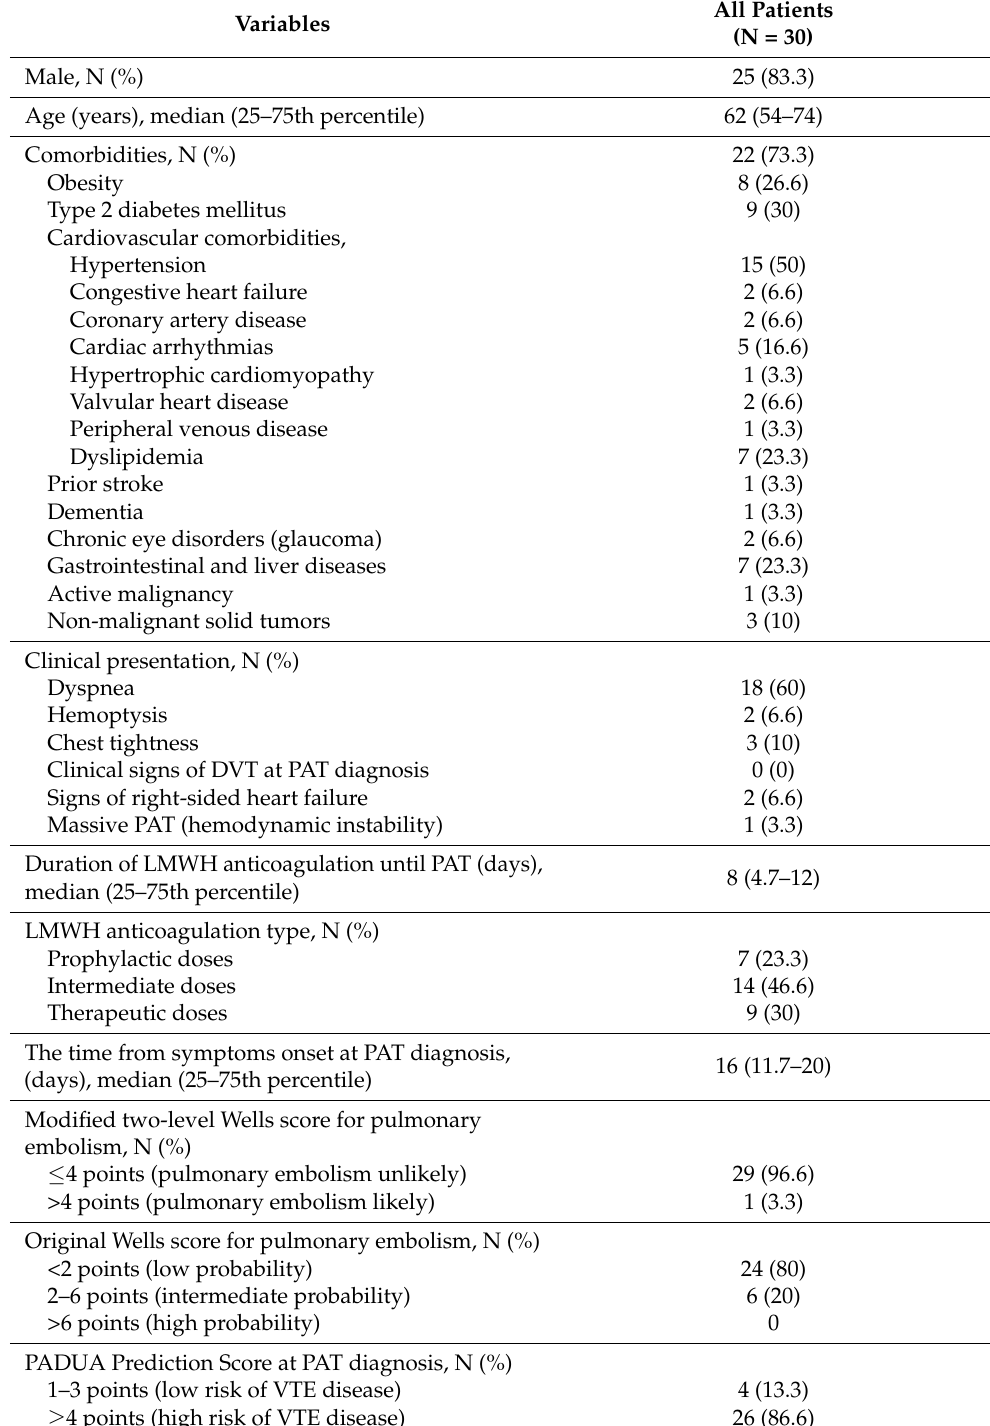
Table 1. Demographics, clinical characteristics and imaging data of patients with